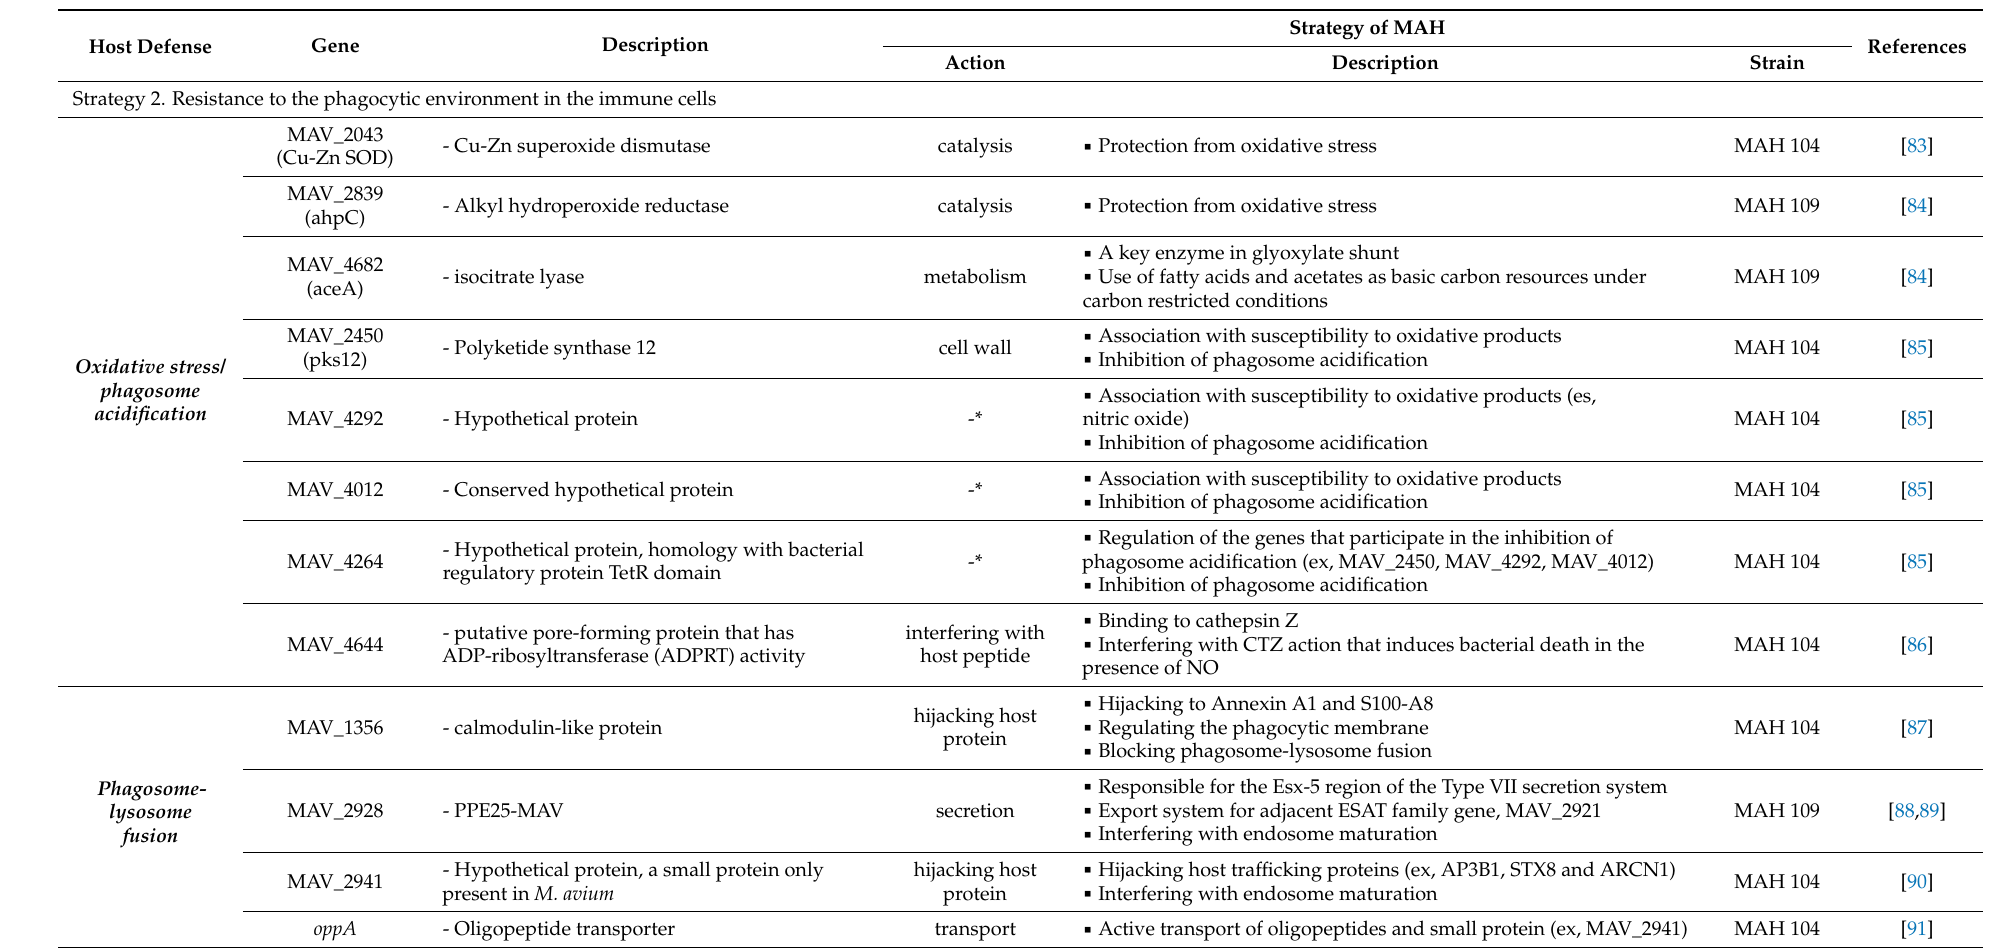
Table 2. Cont. Table 2. Virulence-associated genes of Mycobacterium avium subsp. hominissuis during the pathogenesis. Table 2. Virulence-associated genes of Mycobacterium avium subsp. hominissuis during the pathogenesis. Table 2. Virulence-associated genes of Mycobacterium avium subsp. hominissuis during the pathogenesis. Table 2. Virulence-associated genes of Mycobacterium avium subsp. hominissuis during the pathogenesis. Table 2. Virulence-associated genes of Mycobacterium avium subsp. hominissuis during the pathogenesis. Table 2. Virulence-associated genes of Mycobacterium avium subsp. hominissuis during the pathogenesis. Table 2. Virulence-associated genes of Mycobacterium avium subsp. hominissuis during the pathogenesis. Table 2. Virulence-associated genes of Mycobacterium avium subsp. hominissuis during the pathogenesis. Table 2. Virulence-associated genes of Mycobacterium avium subsp. hominissuis during the pathogenesis. Table 2. Virulence-associated genes of Mycobacterium avium subsp. hominissuis during the pathogenesis. Table 2. Virulence-associated genes of Mycobacterium avium subsp. hominissuis during the pathogenesis. Table 2. Virulence-associated genes of Mycobacterium avium subsp. hominissuis during the pathogenesis. Table 2. Virulence-associated genes of Mycobacterium avium subsp. hominissuis during the pathogenesis. Table 2. Virulence-associated genes of Mycobacterium avium subsp. hominissuis during the pathogenesis. Table 2. Virulence-associated genes of Mycobacterium avium subsp. hominissuis during the pathogenesis. Table 2. Virulence-associated genes of Mycobacterium avium subsp. hominissuis during the pathogenesis. Table 2. Virulence-associated genes of Mycobacterium avium subsp. hominissuis during the pathogenesis. Table 2. Virulence-associated genes of Mycobacterium avium subsp. hominissuis during the pathogenesis. Table 2. Virulence-associated genes of Mycobacterium avium subsp. hominissuis during the pathogenesis. Table 2. Virulence-associated genes of Mycobacterium avium subsp. hominissuis during the pathogenesis. Table 2. Virulence-associated genes of Mycobacterium avium subsp. hominissuis during the pathogenesis. Table 2. Virulence-associated genes of Mycobacterium avium subsp. hominissuis during the pathogenesis. Table 2. Virulence-associated genes of Mycobacterium avium subsp. hominissuis during the